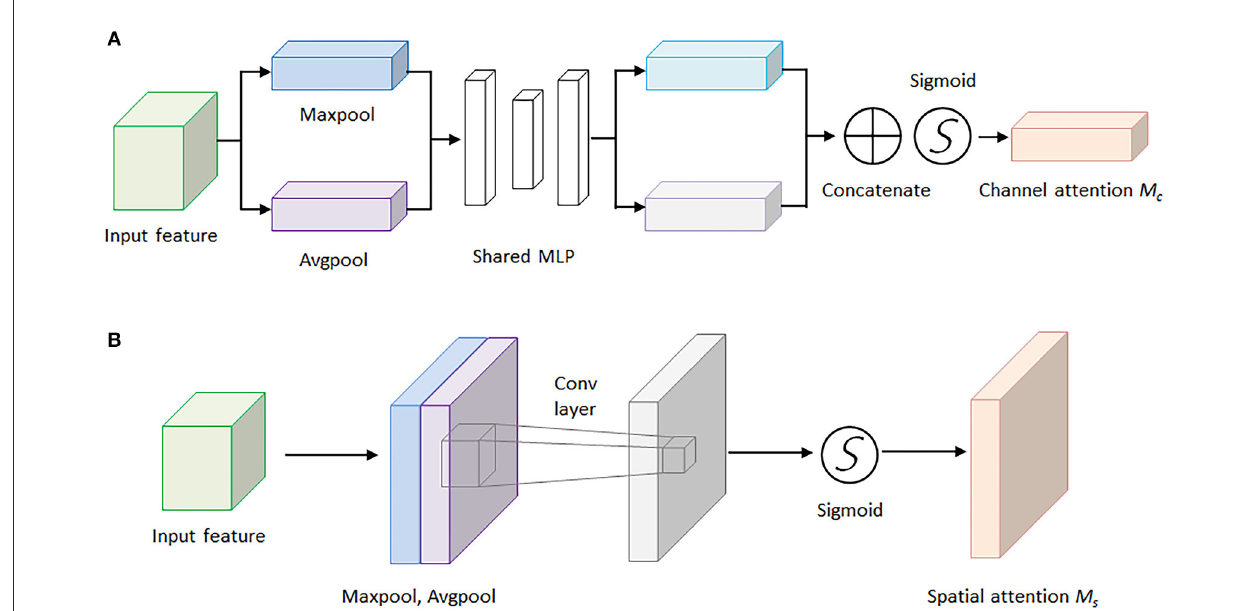
FIGURE5 The architectures of the channel attention module and spatial attention module. (A) Channel attention module. (B) Spatial attention module.